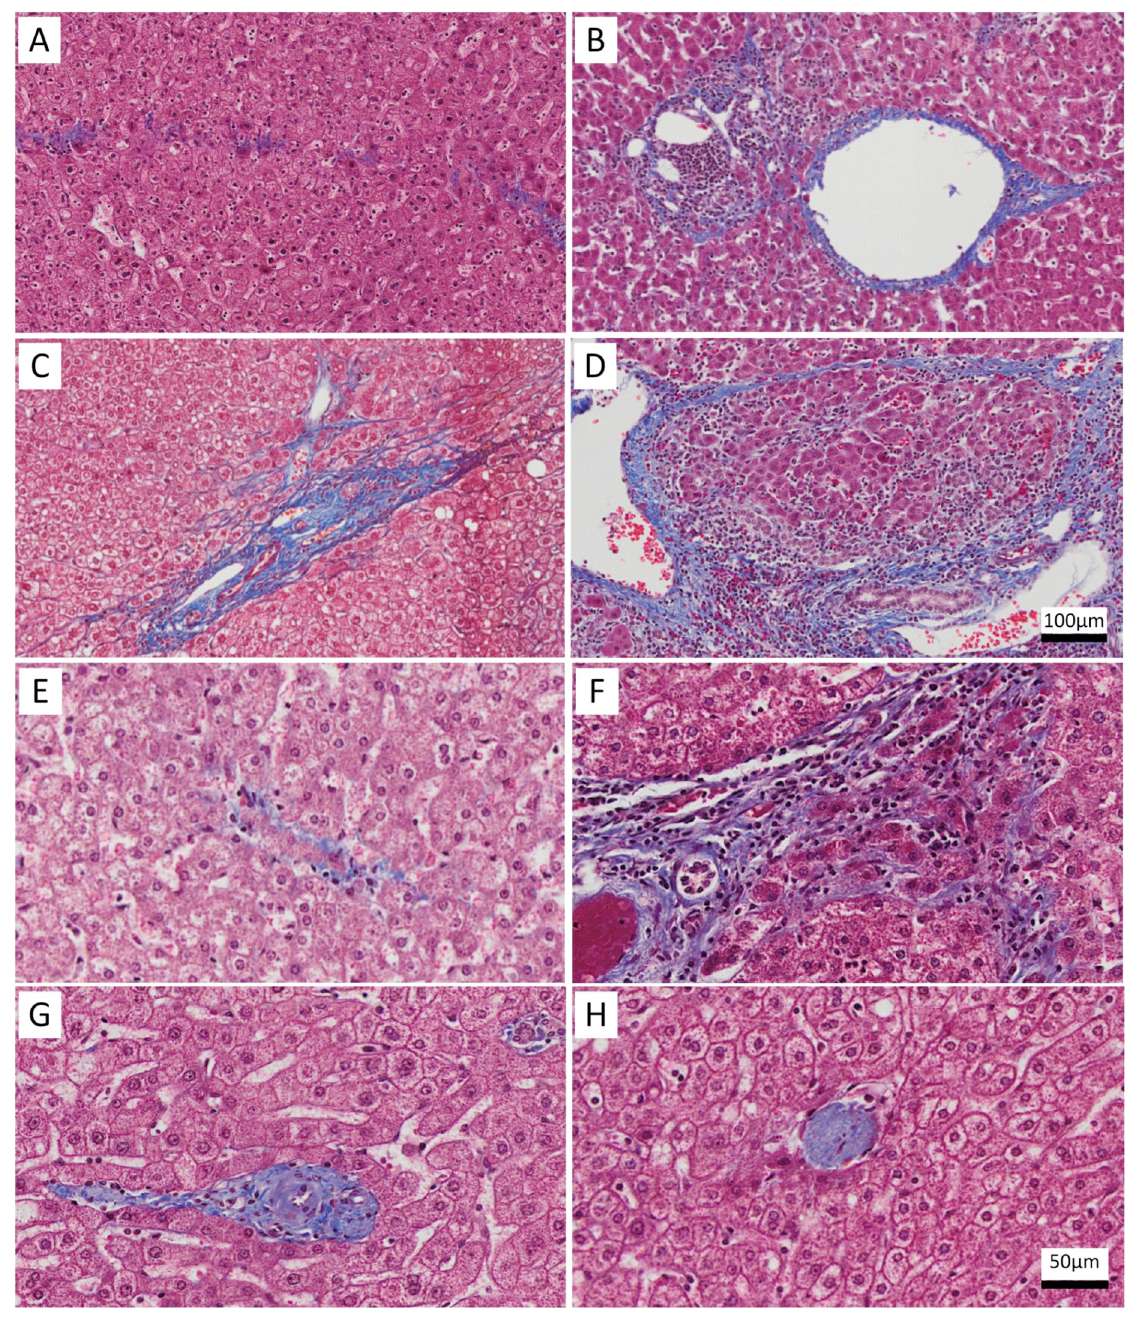
Fig 1. Features of the hepatic repair complex (Trichrome stain). Perforated delicate septa (A); aberrant parenchymal vein (B); delicate periportal fibrous spikes (C); minute regenerative nodule (D); hepatic vein remnant with prolapsed hepatocytes (E); hepatocytes within portal tracts or split septa (F); portal tract remnant (G); and isolated collagen bundle (H). The scale bar in panel D applies to panels A-D; the scale bar in panel H applies to panels